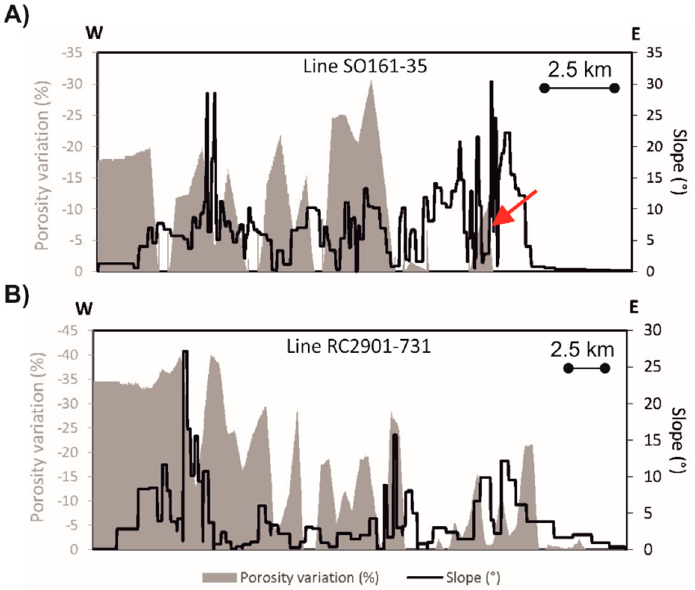
Figure 4. ( A ) Porosity variations due to a gas hydrate presence (grey area) and slope variation (black line) along the line SO161-35. Red arrow indicates the zone characterized by a high seafloor slope and a shallow depth of bottom simulating reflector (BSR). ( B ) Porosity variations due to a gas hydrate presence (grey area) and slope variation (black line) along the line RC2901-731.